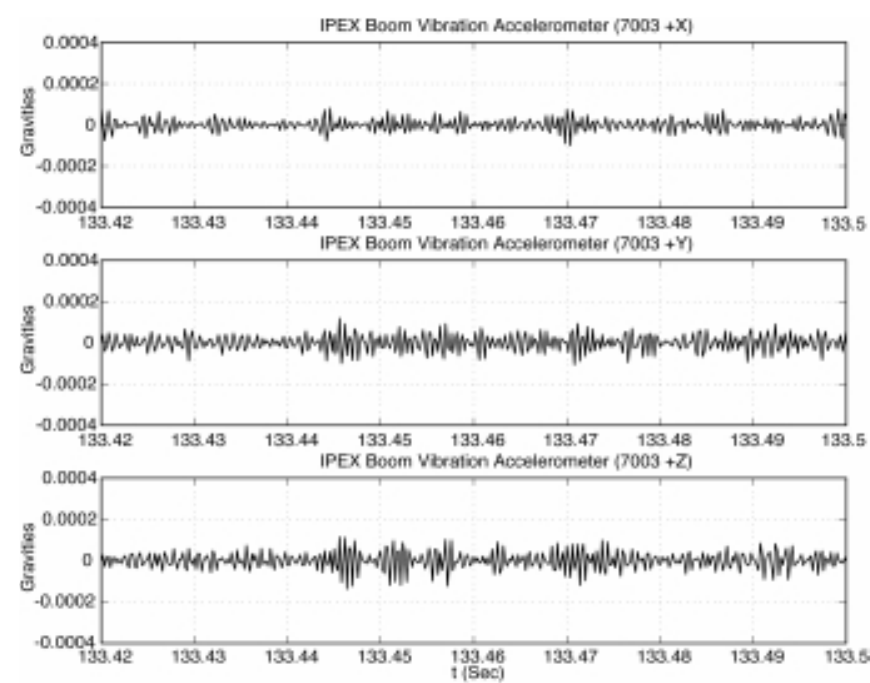
Fig. A3. Event 1 Node